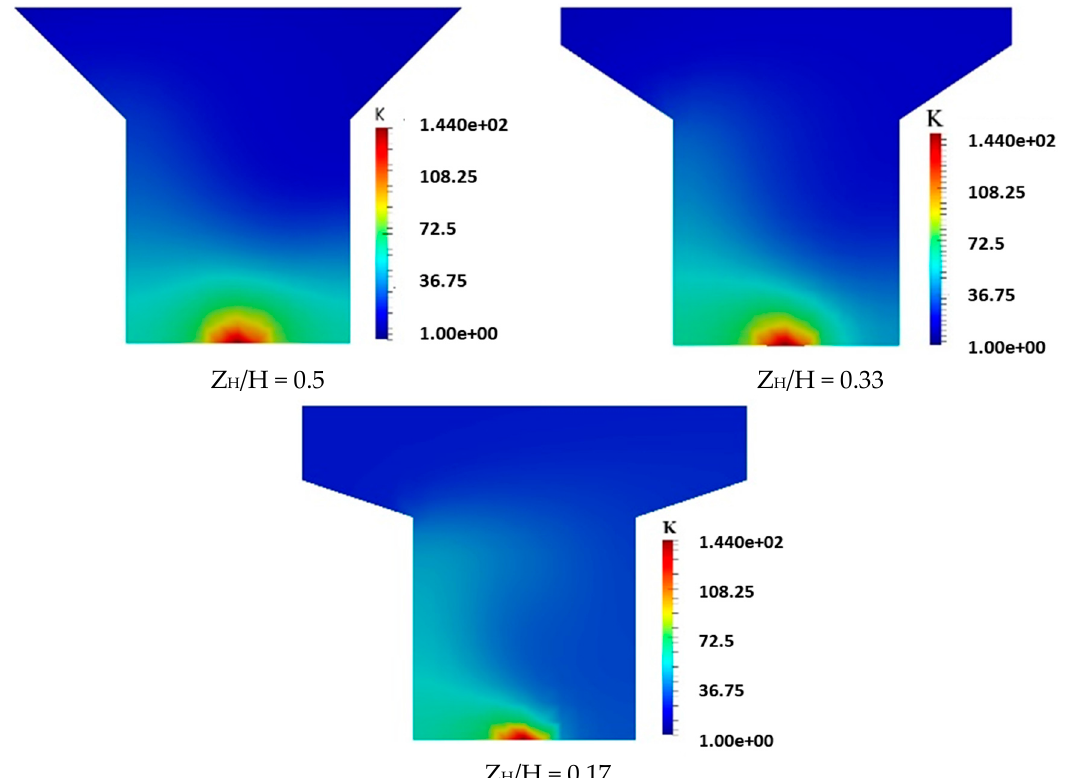
Figure 21. Distribution of concentration K in the street canyons with slanted roofs.